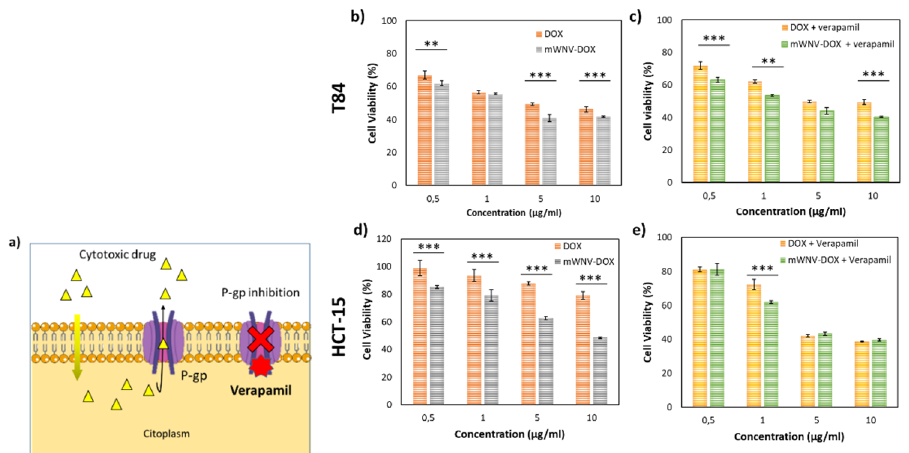
Figure 3. Encapsulation effect on a DOX-resistant in vitro model. ( a ) Scheme representing the mechanism of action of verapamil. ( b , c ) Cell viability of T84 cells in 2D cultures after 48 h of exposure to a wide range of DOX (orange) and mWNV-DOX (grey) ( b ) and DOX + verapamil (yellow) and mWNV-DOX + verapamil (green) ( c ). ( d , e ) Cell viability of HCT-15 cells in 2D cultures after 48 h of exposure to a wide range of DOX (orange) and mWNV-DOX (grey) ( d ) and DOX + verapamil (yellow) and mWNV-DOX + verapamil (green) ( e ) (mean ± SEM; ** p < 0.005, *** p < 0.001, Student’s t- test).